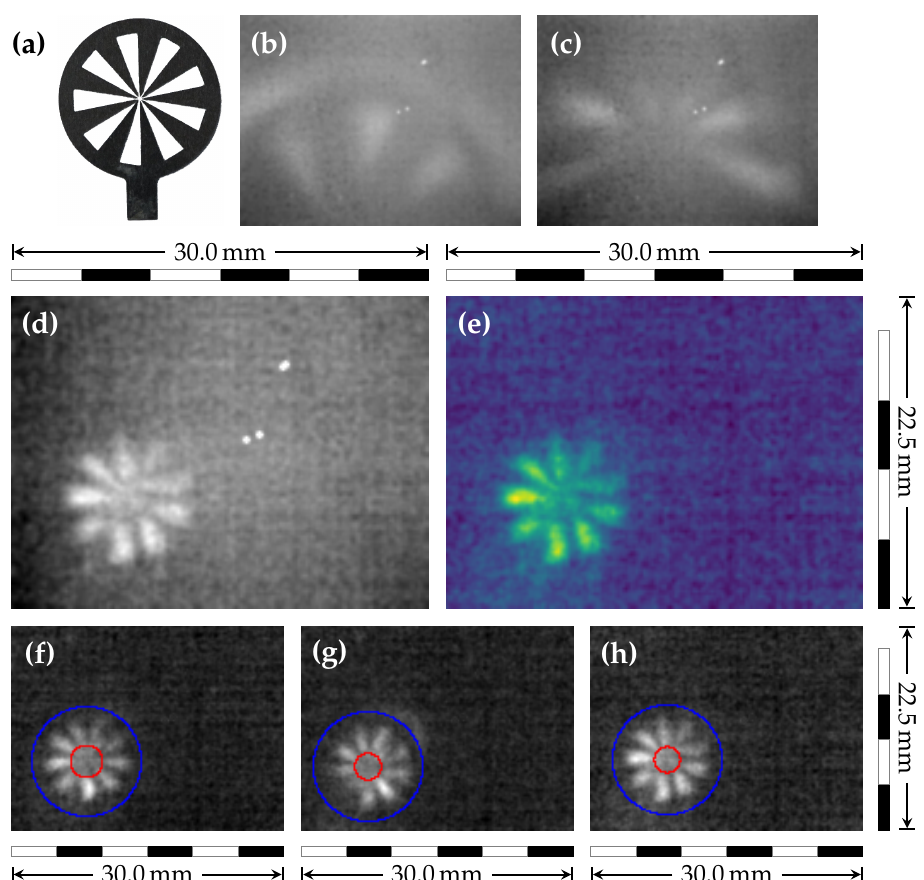
Figure 4. Imaging of a metallic Siemens star. Photography (VIS) of the Siemens star ( a ). Unprocessed THz images acquired in zigzag THz-TDS geometry (see Figure 1): Image with the outer rim of the Siemens star visible ( b ), whereas, in ( c ), only the central part is resolved. THz images acquired in lens-based setup (see Figure 2): unprocessed THz data ( d ) and false-color with dead-pixel-removal applied ( e ). Determination of the resolution shown with three example frames ( f – h ): The assumed outer rim of the Siemens star (blue circles) and resolution limit of 1.23mm ( f ), 1.02mm ( g ), and 0.99mm ( h ) (red